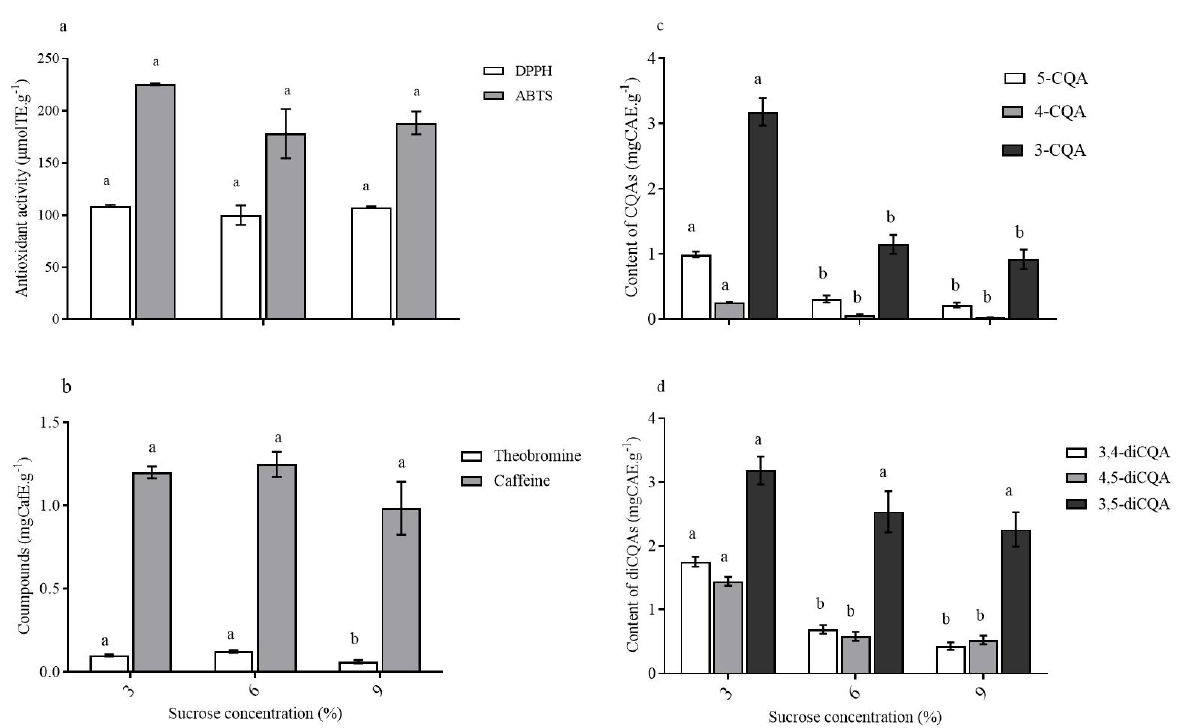
Figure 5. Effect of sucrose concentration on the: a) Antioxidant activity, b) Theobromine and caffeine, c) Chlorogenic acids and d) Dicaffeoylquinic acids of I. paraguariensis callus culture after 120 days. Means with different letters are significantly different at the 5% probability level according to the Tukey’s multiple range test. The vertical bars represent the standard error of five